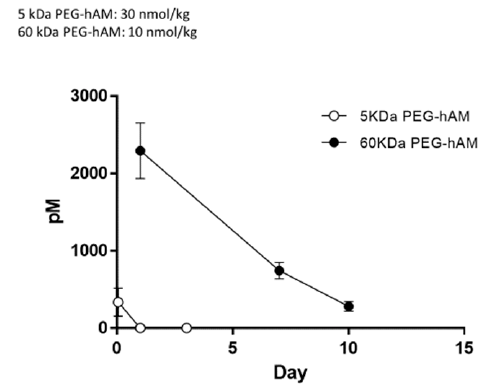
Figure 6. PEGylated human adrenomedullin (PEG-hAM) has a prolonged half-life in the blood. Plasma disappearance of 5 kDa PEG-hAM (open circles) and 60 kDa PEG-hAM (closed circles) over time. Five kDa PEG-AM (30 nmol/kg) and 60 kDa PEG-AM (10 nmol/kg) were injected subcutaneously into anesthetized rats, and blood samples were taken at the indicated time points (modified and redrawn from [50]).